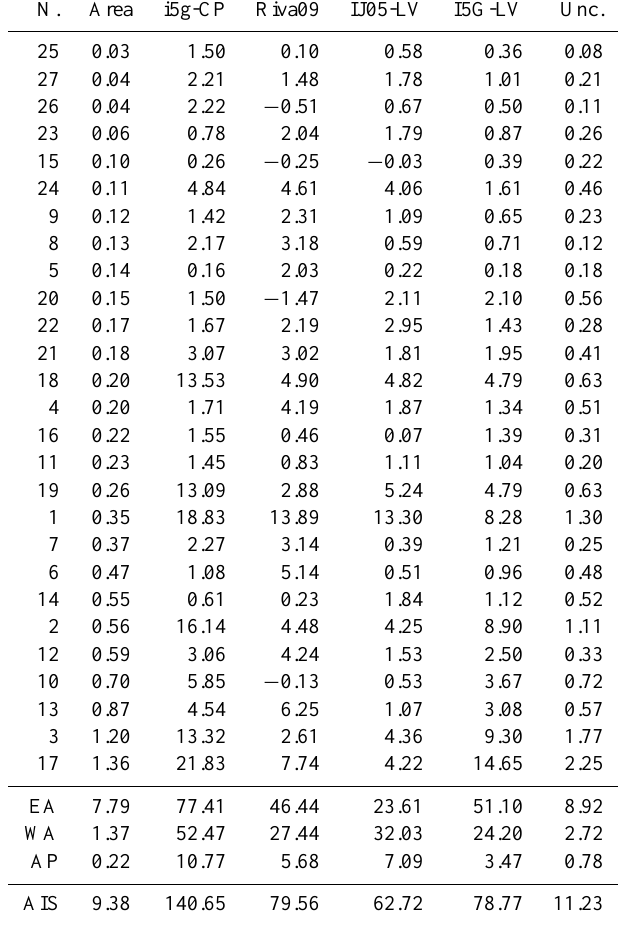
Table 4. GIA trends for Antarctica. The first column is the basin number, the second its area (in 10 6 km 2 ) and from the third column the values are in Gt yr − 1 , and they report the values for the four models, namely ICE5g-VM2 compressible with rotational feed- back, Riva09, IJ05-LV and ICE5g-LV. The last column reports the maximum uncertainty among the last three models. The basins are sorted from the smallest to the largest.